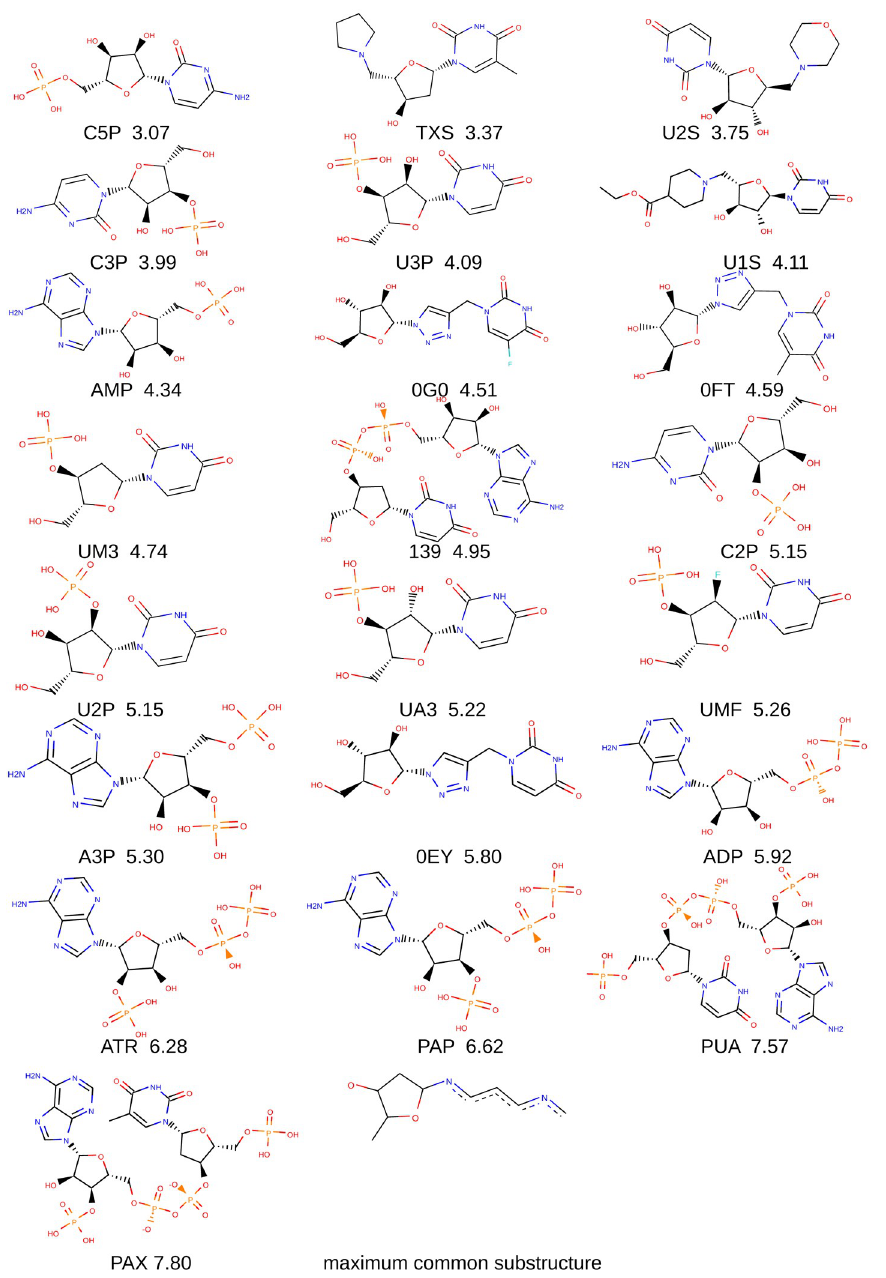
Fig 1. Ligand molecules examined in the present study and their maximum common substructure. Below each ligand, we give its name and its p K value for RNase A. All p K values are p K i s, except for PAX, which is a p K d. Therefore, throughout the present report, we refer to these values simply as p K s. Note that phosphate groups are drawn protonated, whereas they have been simulated in a fully deprotonated